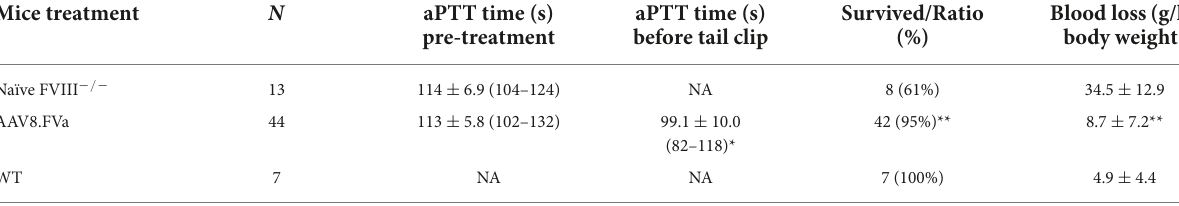
TABLE 1 Phenotypic correction of tail clip in FVIII − / − mice treated with AAV8/hFVa vectors. Mice treatment N aPTT time (s)